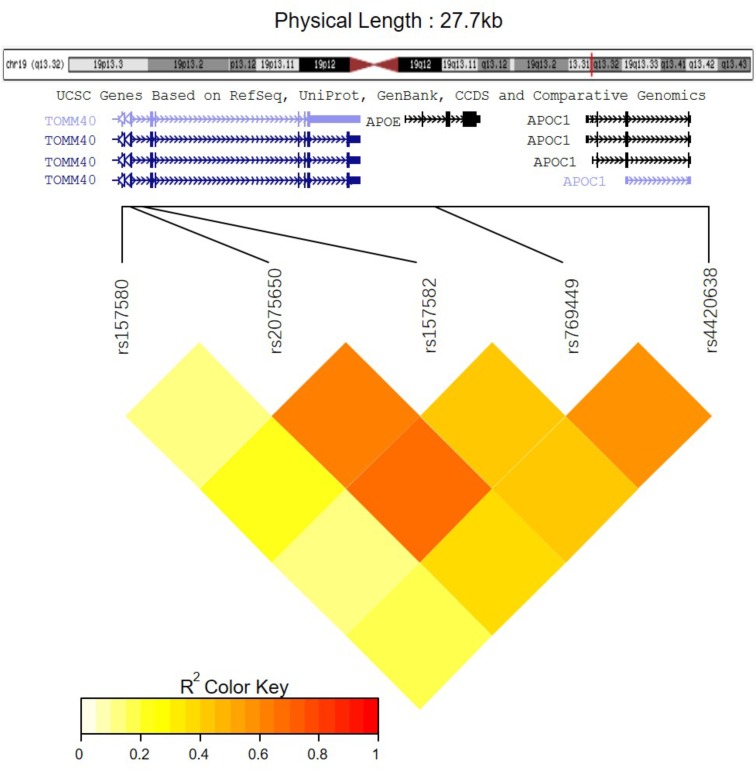
The LD pattern for the five significantly associated SNPs.